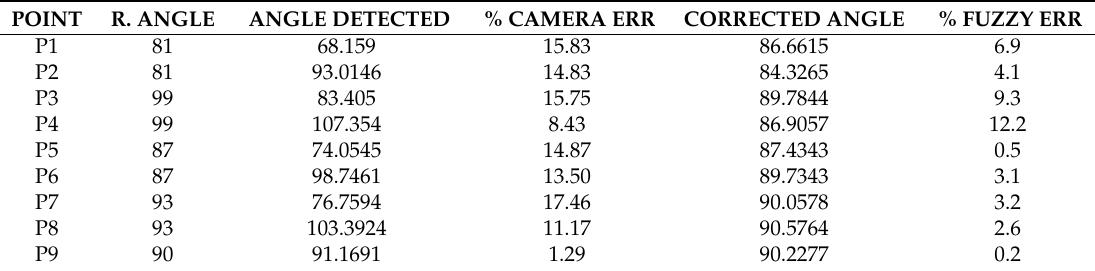
Table 3. Results obtained after having processed the information through the Fuzzy